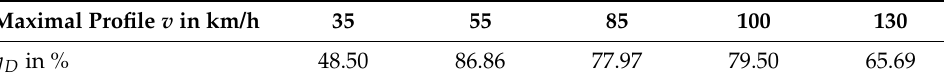
Table 5. Drivetrain efficiency data.